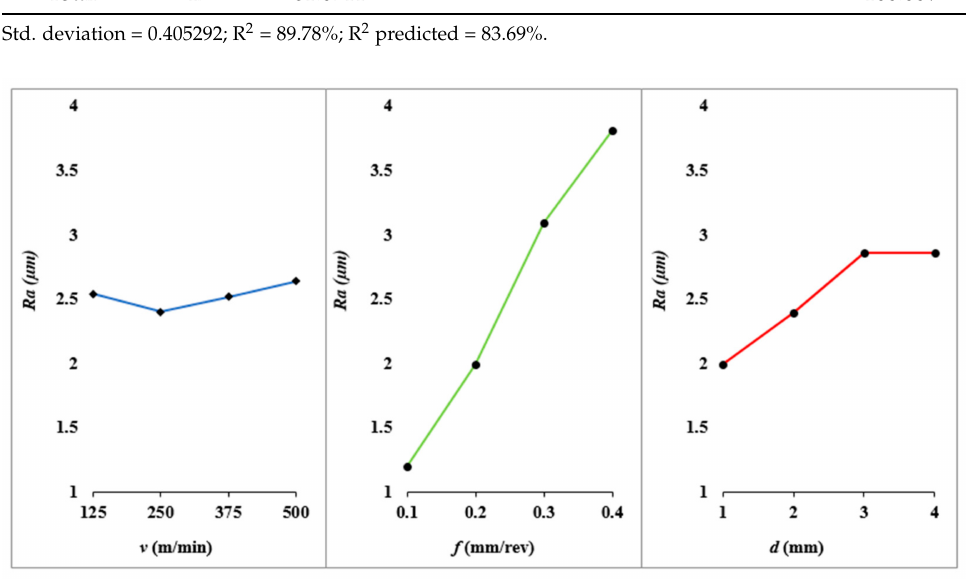
Figure 5. Main effect plot showing the influence of cutting parameters on Ra in CSM.